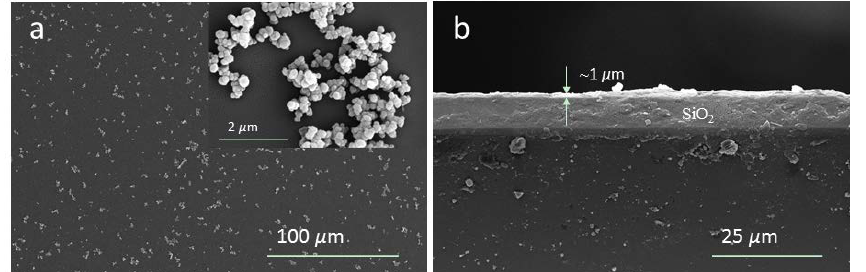
Figure 3. SEM images of a PDA layer formed on a silicon wafer surface, showing aggregates on the surface ( a ) and a PDA layer thickness of ~1 μm ( b ). The concentration of dopamine used for the polymerization is 2 mg/mL.